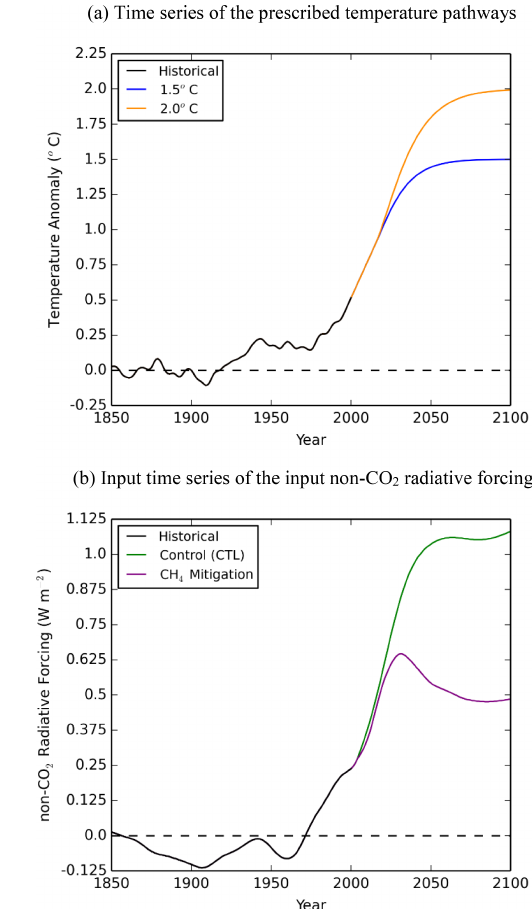
Figure 3. Time series of key datasets used in the study. (a) The his- toric temperature record (black) and the prescribed temperature pro- files used to represent warming of 1.5 ◦ C (blue) and 2 ◦ C (orange). (b) The historic (black) and the projected non-CO 2 greenhouse gas radiative forcing (Wm − 2 ) for the control (green) and methane mit- igation (purple)